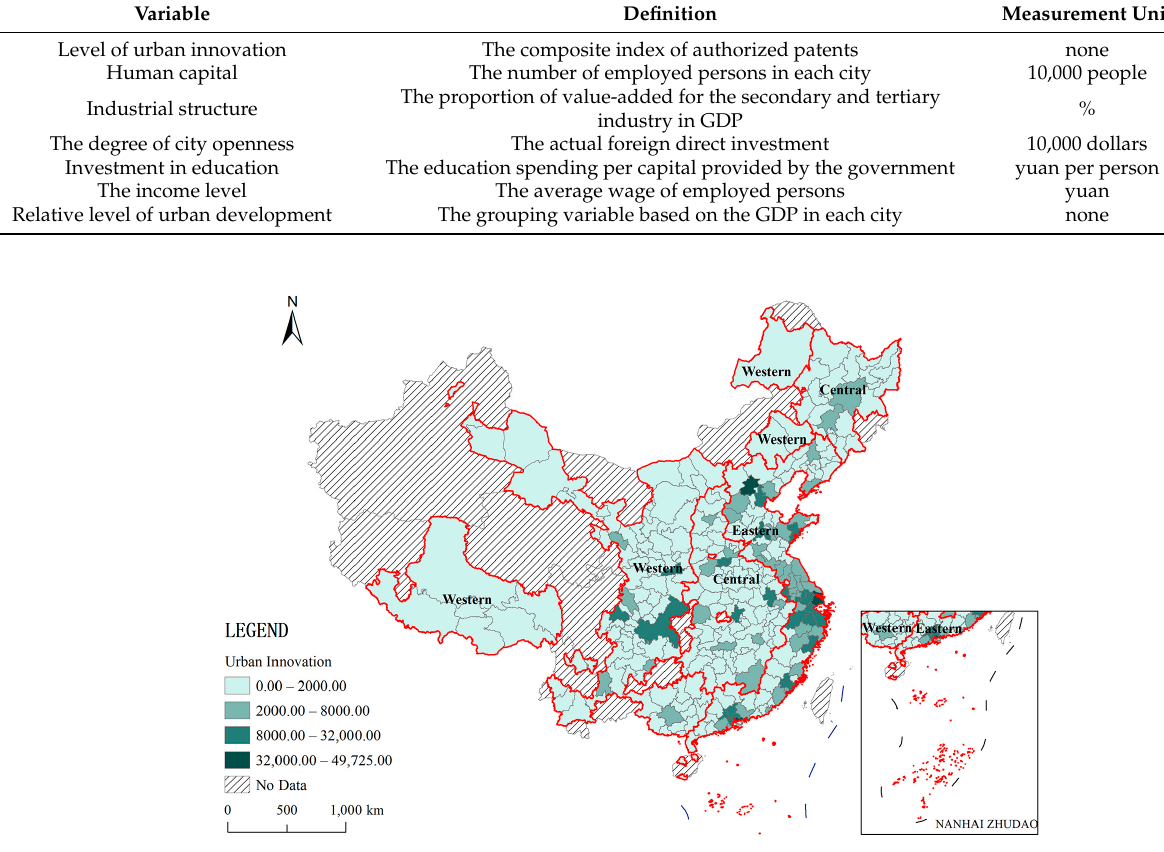
Figure 1. The distribution of the level of urban innovation in 2019.